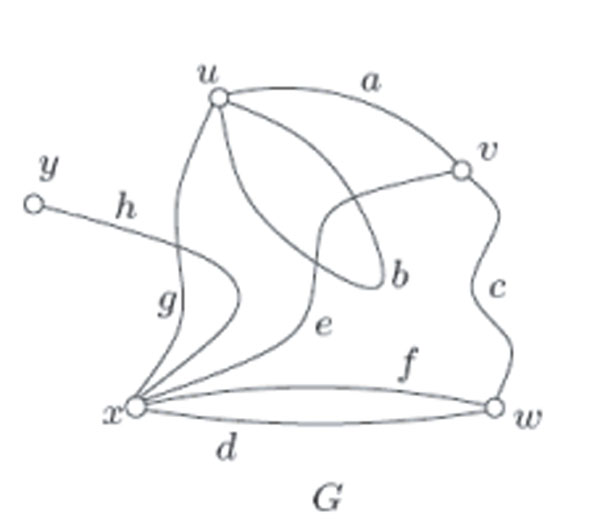
An example of graph G[6].